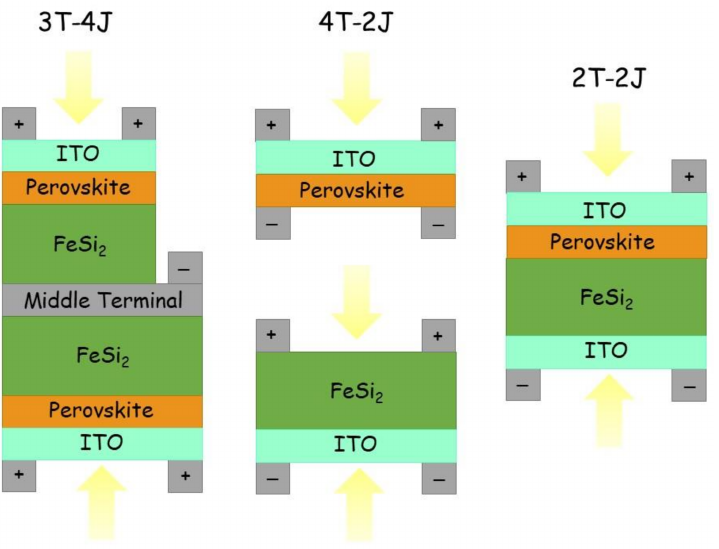
Figure 10. Scheme of 3T-4J, 4T-2J, and 2T-2J configurations of bifacial tandem solar